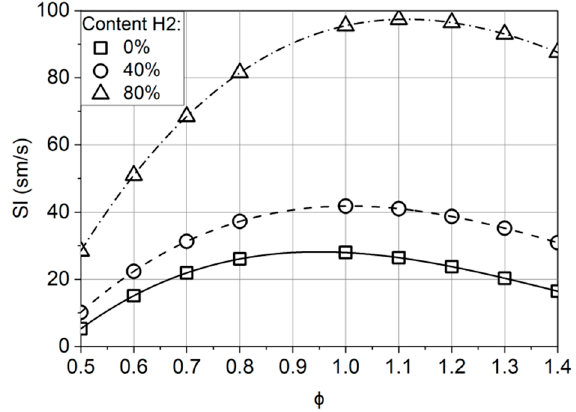
Figure 3. Influence of the molar fraction of hydrogen on the flame propagation speed of a methane- hydrogen mixture at atmospheric pressure and 300 K [9,10].